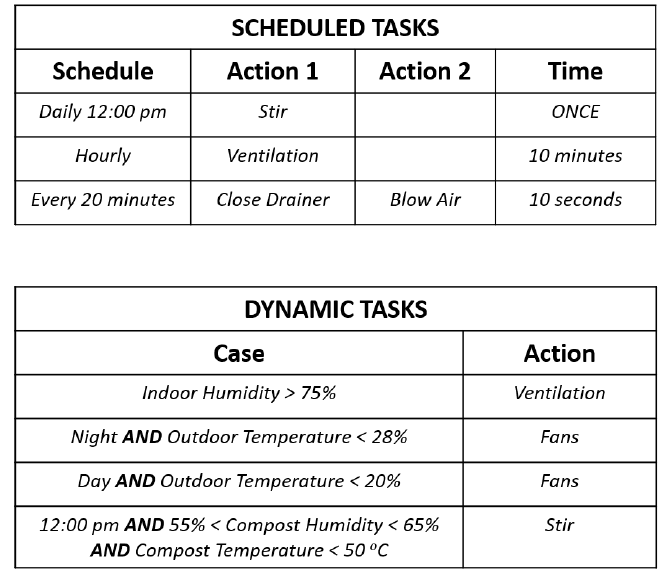
Figure 8. Task assignment to the IoT gateway.